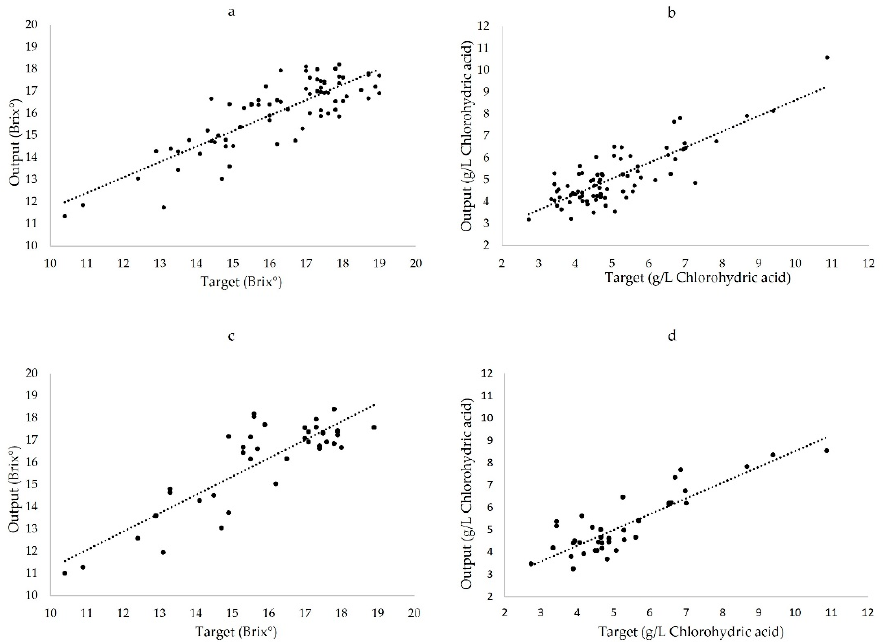
Figure 8. Output of the ANN models versus the validation data excluded during training at every iteration of the LOOCV (SSC ( a ) and TA ( b )) and random sampling (SSC ( c ) and TA ( d )).